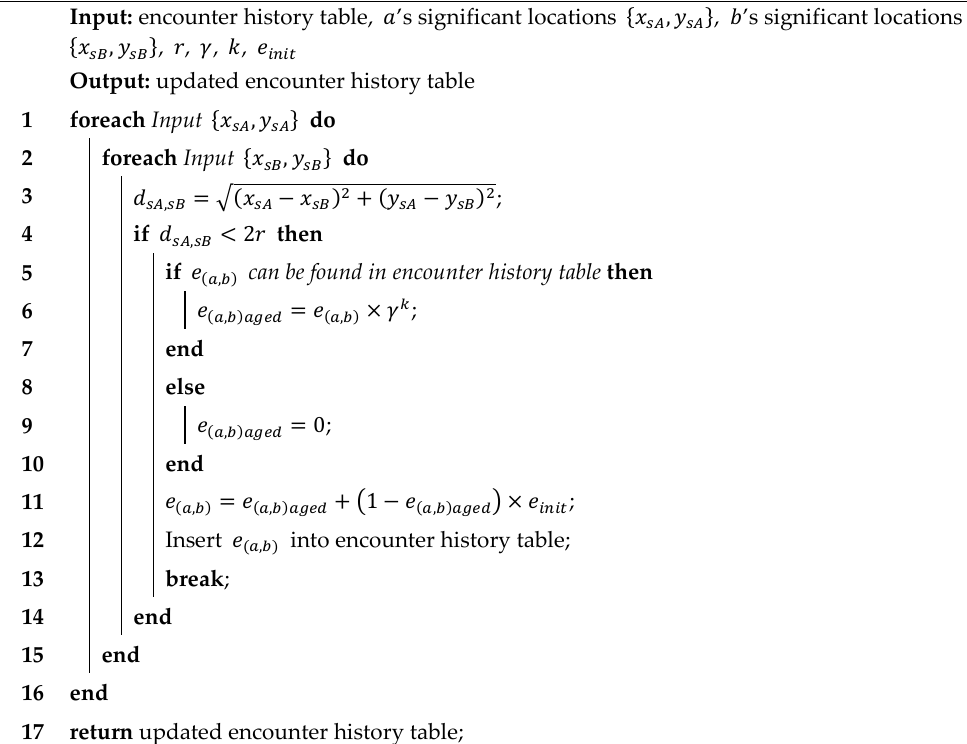
Algorithm 2 The algorithm for updating the encounter history table with PoiEncounters